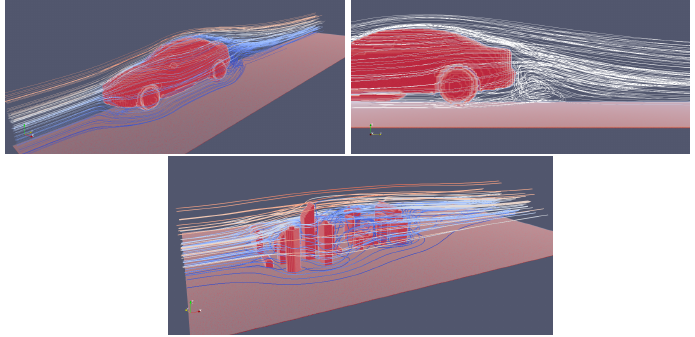
Figure 5. The snapshot of the external flow simulation and streamlines using Taichi-LBM3D with computational domain 200 × 600 × 200 and 300 × 400 × 200. The fluid viscosity is 0.1 in the lattice unit, and dt = 1 in the lattice unit.